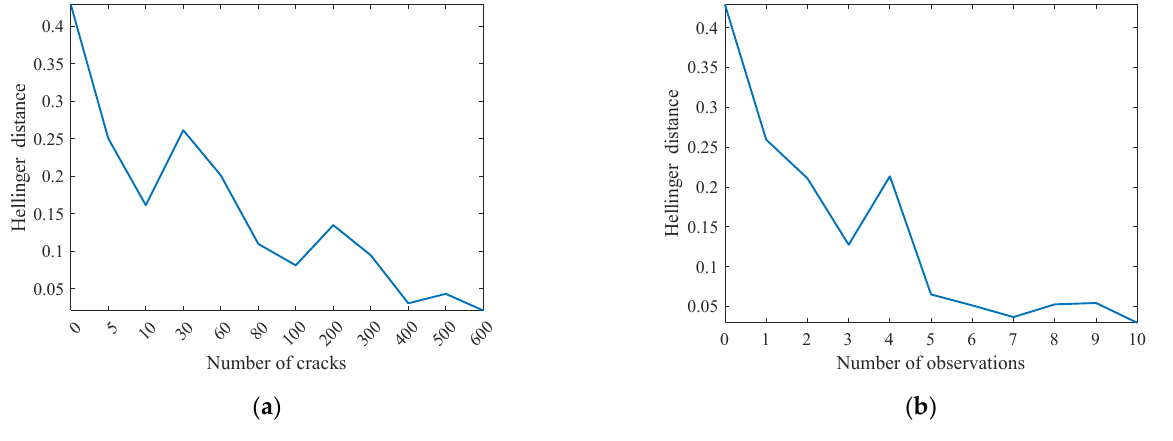
Figure 13. Hellinger distance variation between updated and ground-truth distributions of initial crack size using spatial–temporal inspection data. ( a ) Number of cracks. ( b ) Number of observa- tions.